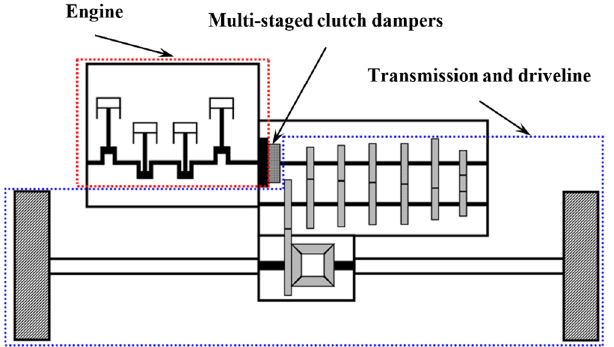
Figure 1. A physical driveline system based on the front-engine and front-wheel layout with multi-staged clutch dampers 22 .